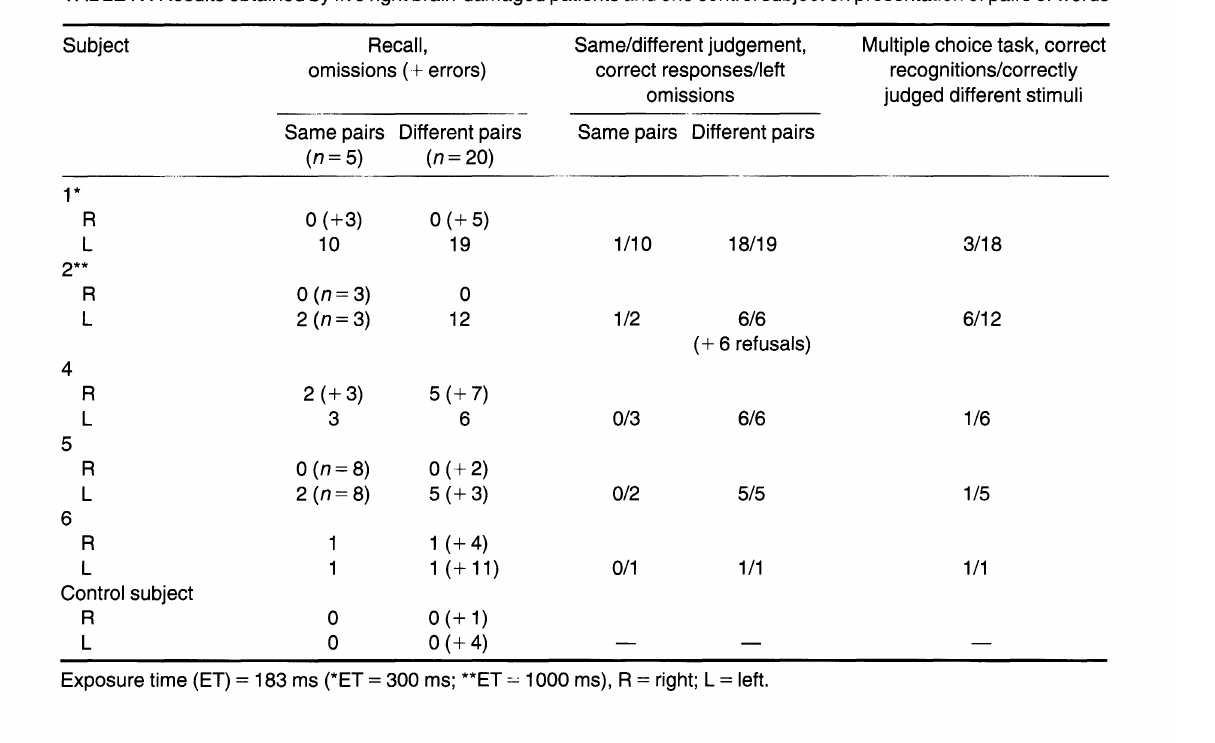
TABLE IV. Results obtained by five right brain-damaged patients and one control subject on presentation of pairs of words Subject